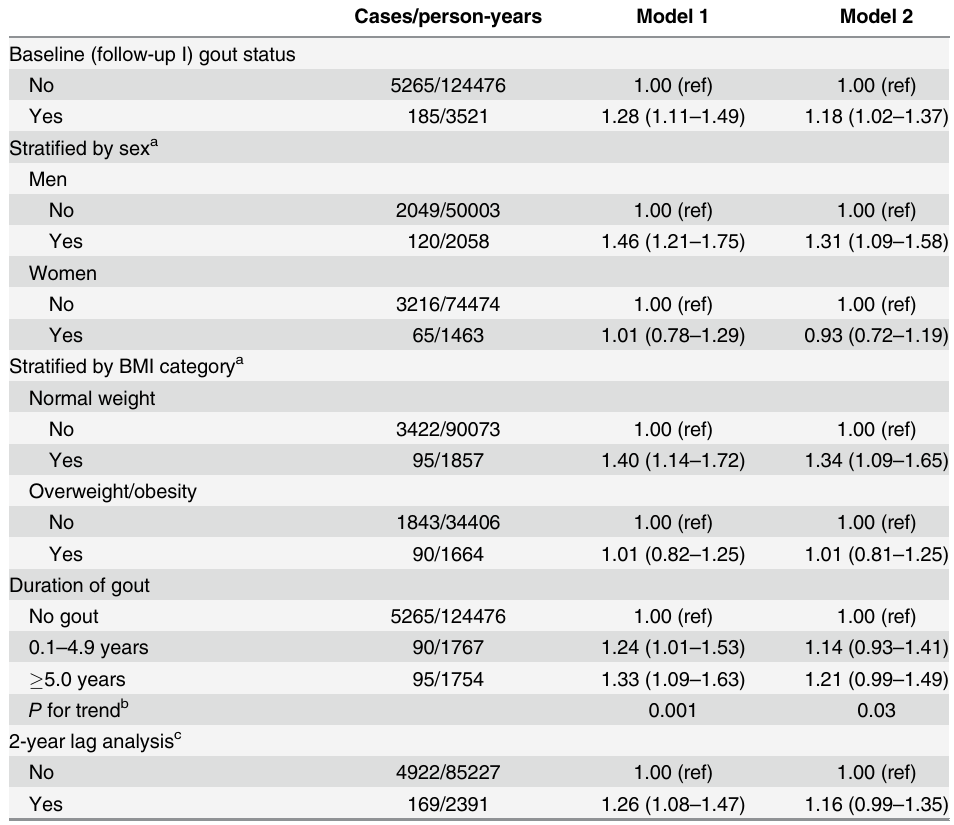
Table 3. Hazard ratios (95% confidence intervals) for risk of hypertension according to gout status: The Singapore Chinese Health Study (1999 –